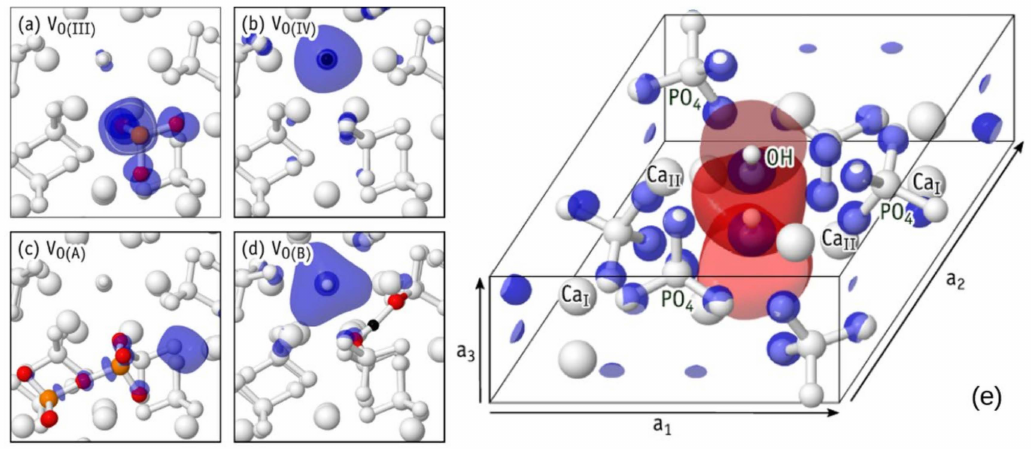
Figure 11. Electron density isosurfaces from the highest occupied Kohn − Sham level of neutral V O defects in HAP. The density of V O(III) in ( a ) is representative of V O(I) and V O(II) as well. The density of V O(IV) in ( b ) shows the case of a missing O(IV) atom, leaving an isolated H atom in the OH channel. The density of extended charged defects V O(A) and V O(B) are shown in ( c , d ) (description is in text). Isosurfaces are drawn at constant electron density n = 0.001 Å − 3 . Reprinted with permission from [8]. Copyright (2019) American Chemical Society. ( e ) Lowest unoccupied Kohn-Sham state (bottom of the conduction band) of a HAP at k = G. Blue and red isosurfaces represent y( r ) = +0.02 and y( r ) = 0.02 phases of the wave function, respectively. All atoms are shown in white. Reprinted with permission from [7]. (Adapted with permission from [7]. CCC (2018) AIP